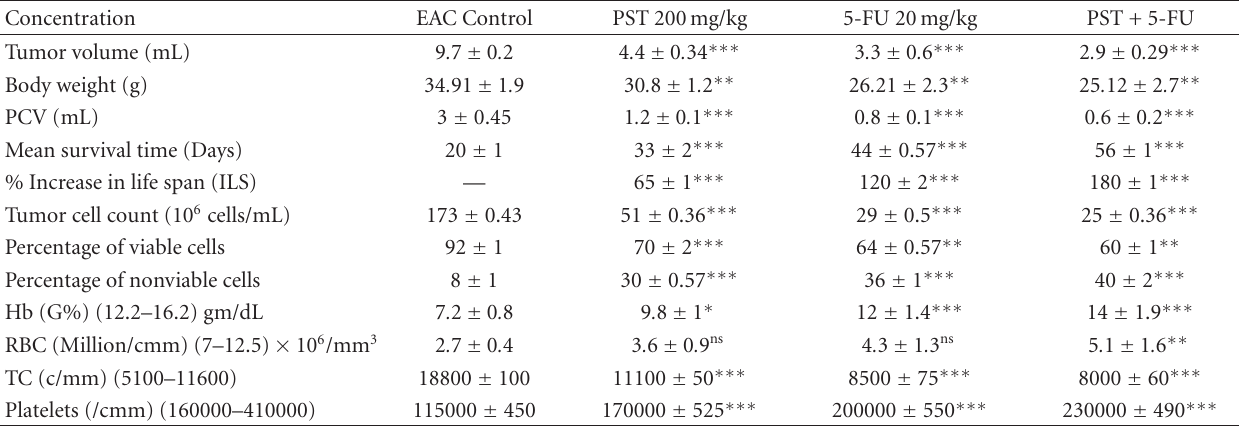
Table 5: Tumor and hematological characteristics in mice injected with drug for 7 days, EAC administered on 8th day, observed for 21 days and dissected on 22nd day (Group